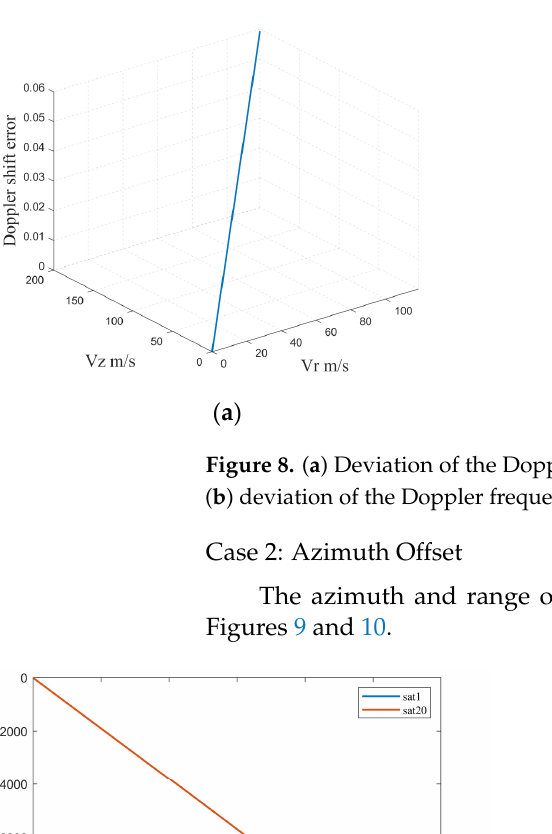
Figure 7. ( a ) Doppler centroid with the velocity of the 1st and 20th image under the acceleration; ( b ) Doppler frequency rate with the velocity of the 1st and 20th image under the acceleration.